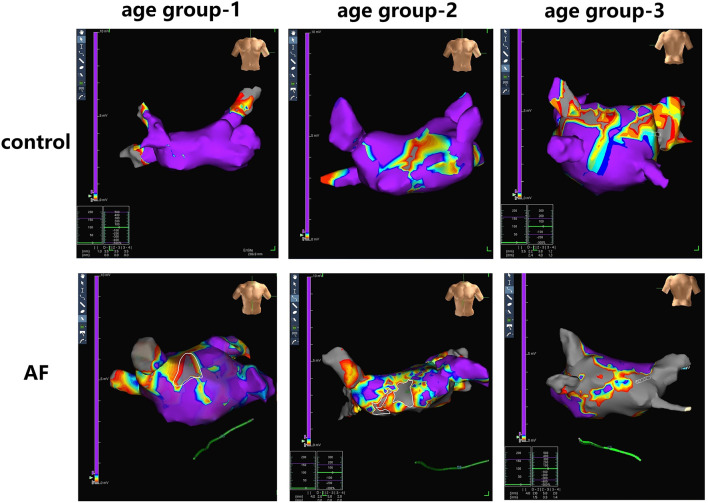
Examples of LA fibrosis burden in control individuals and AF patients at three age groups. Different values of electrical voltage representing LA fibrosis are color-coded in purple to gray. Purple region, gray region and other color region represent completely healthy myocardial tissue with a voltage ≥0.5 mV, scar with a voltage ≤0.1 mV, and junction area at the voltage of 0.1- to 0.5-mV region, respectively.